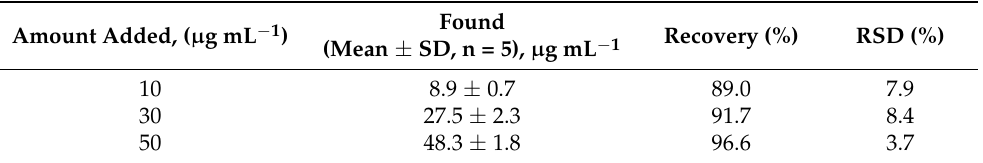
Table 6. Accuracy measurement by the add-found test for CTAB determination in spiked distilled water using the developed Cu-PCV procedure.